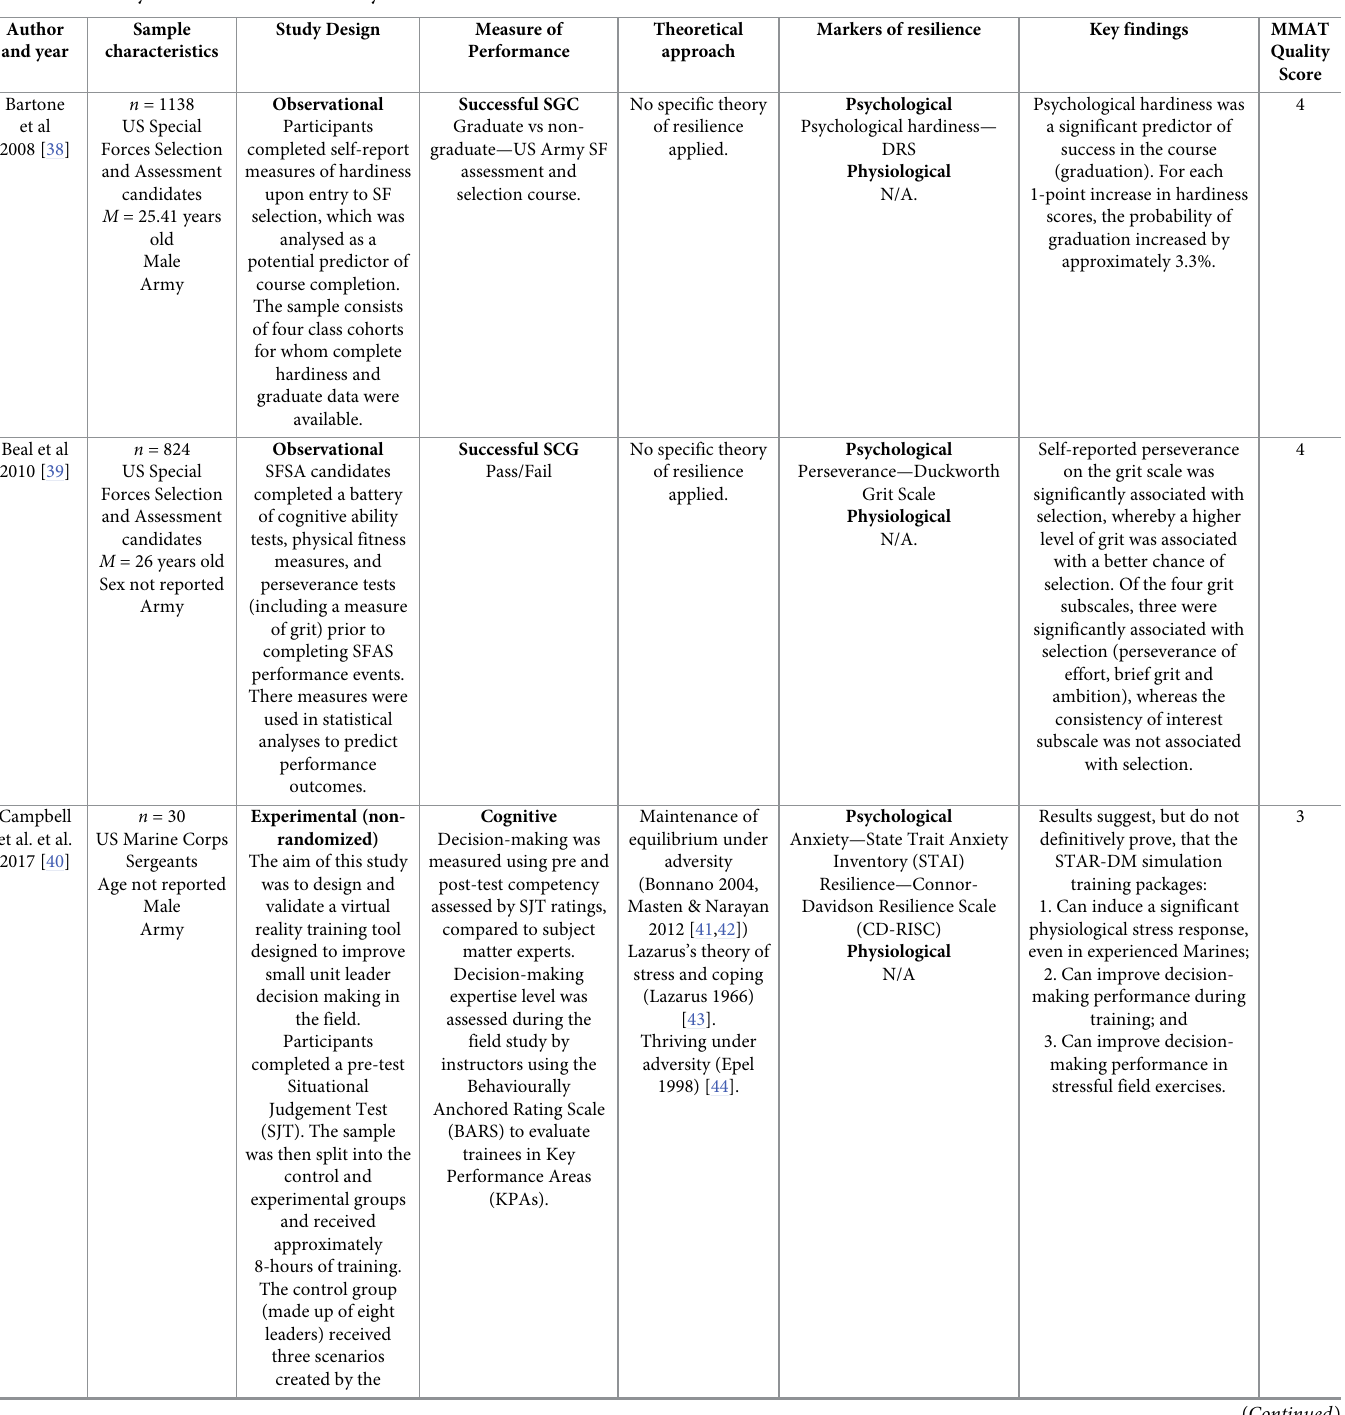
Table 1. Summary of studies included in the systematic